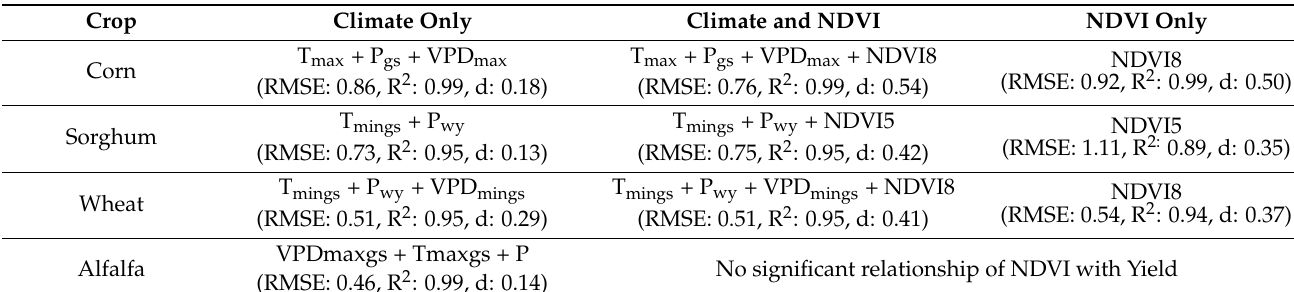
Table 7. Recommendations on appropriate/best crop yield prediction models based on the comparison of climate only, climate and NDVI, and NDVI only analysis